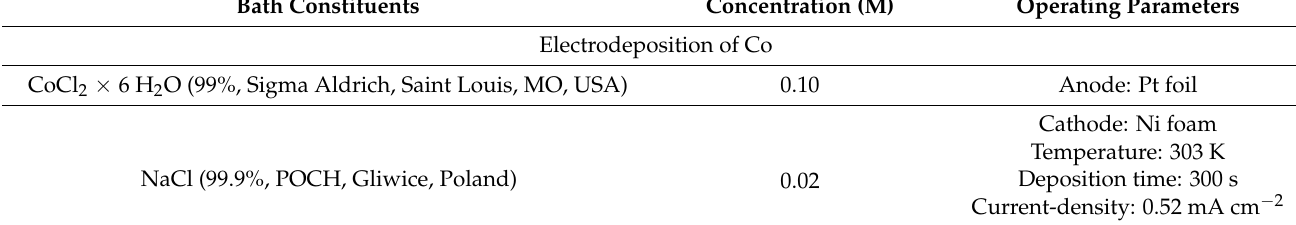
Table 4. Operating parameters and bath compositions employed for electrodeposition of Co and Mo onto Ni foam substrate. Bath Constituents Concentration (M) Operating Parameters Electrodeposition of